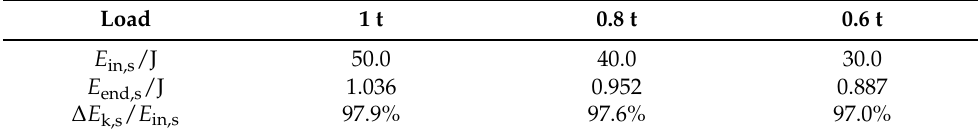
Figure 4. Kinetic energy of the specimen with different loads. Table 1. The kinetic energy value of the